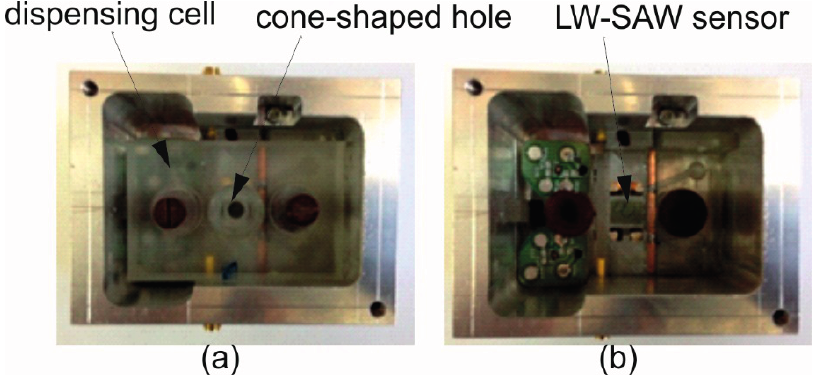
Figure 3. Images of the custom-made LW-SAW cell: ( a ) complete testing cell; ( b ) the testing cell without the dispensing